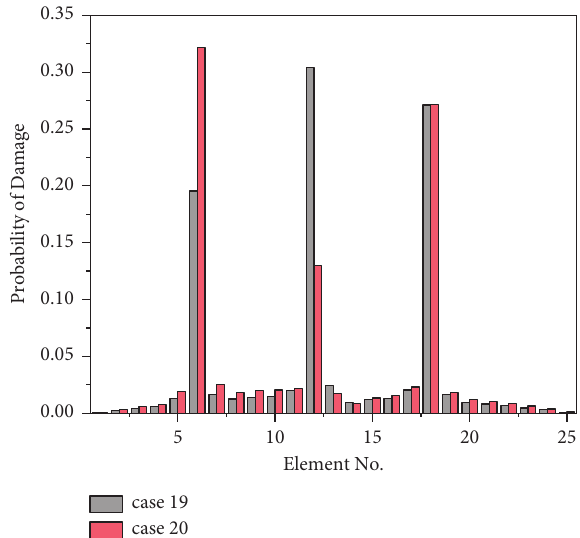
Figure 13: Recognition results of second-level fusion for multi-